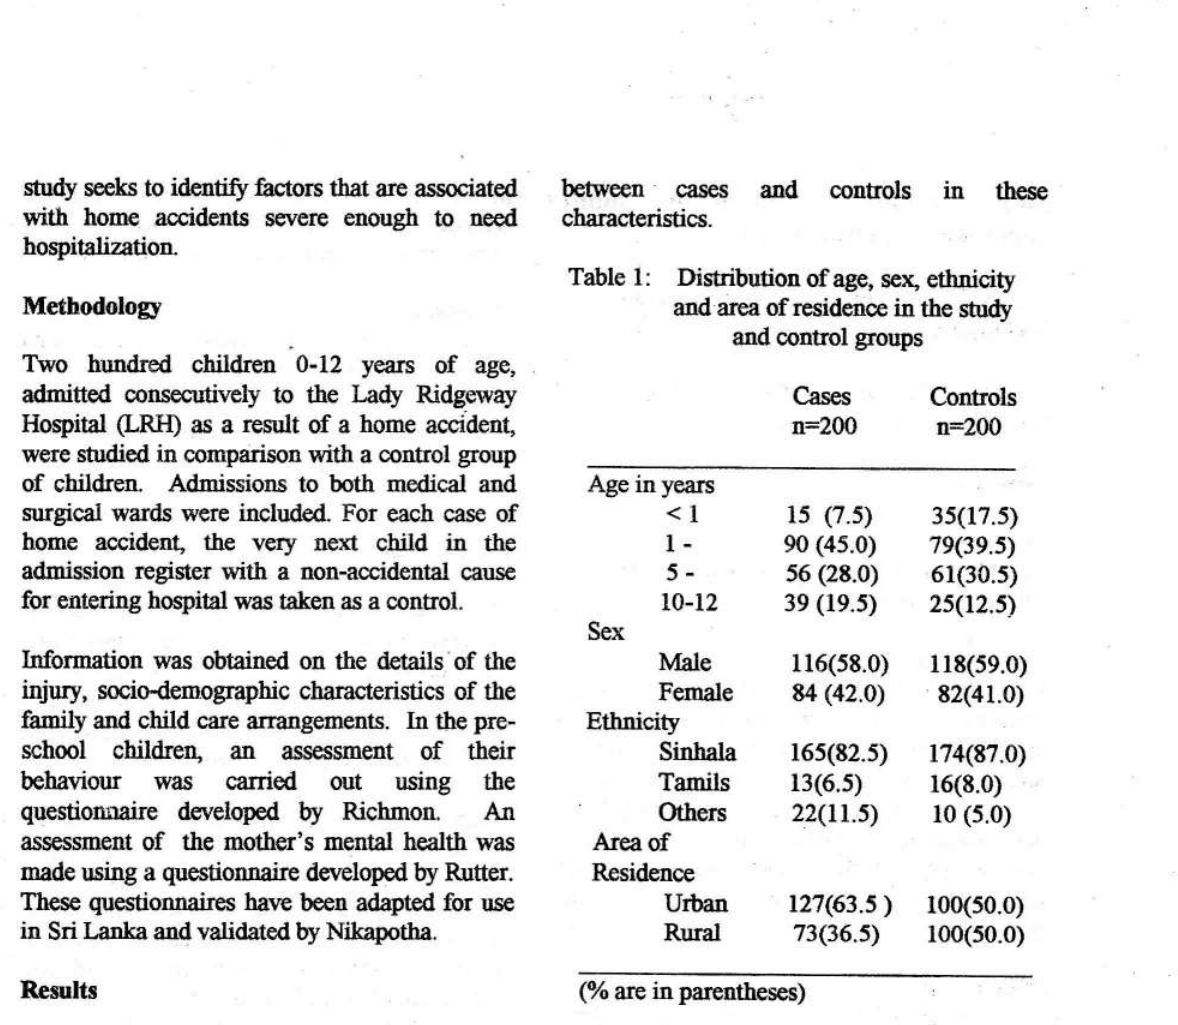
1: Distribution of agg sex, ethnicity Table and area ofresidence in the study and control